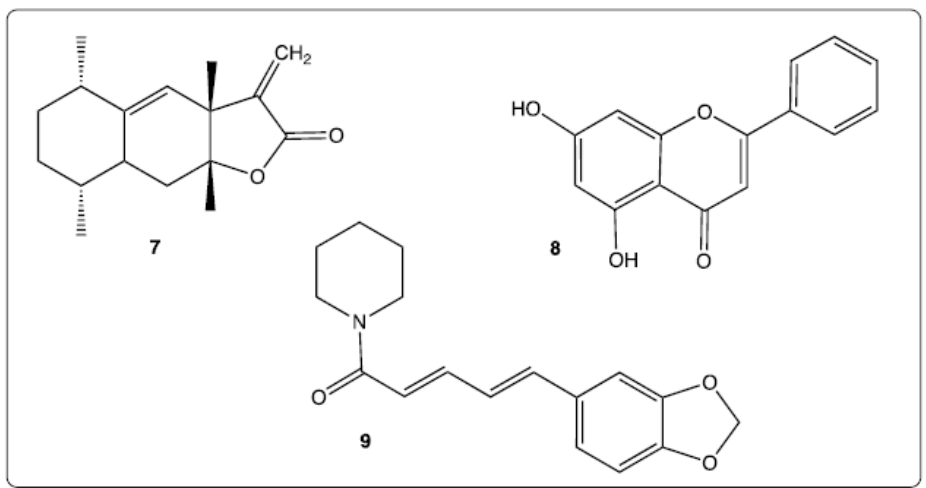
Figure 5. Chemical structures of co-encapsulated compounds: alantolactone ( 7 ), chrysin ( 8 ), piperine ( 9 ).